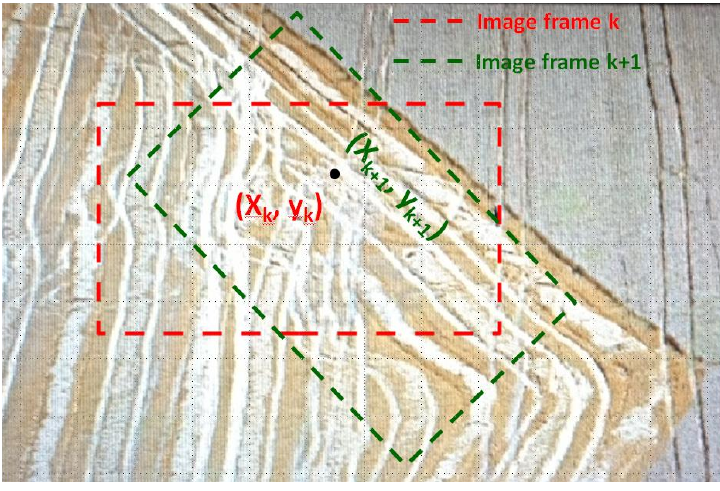
Example showing two successive observation areas taking over an object, highlighting the variation in the coordinates of a single point when referring to two different camera